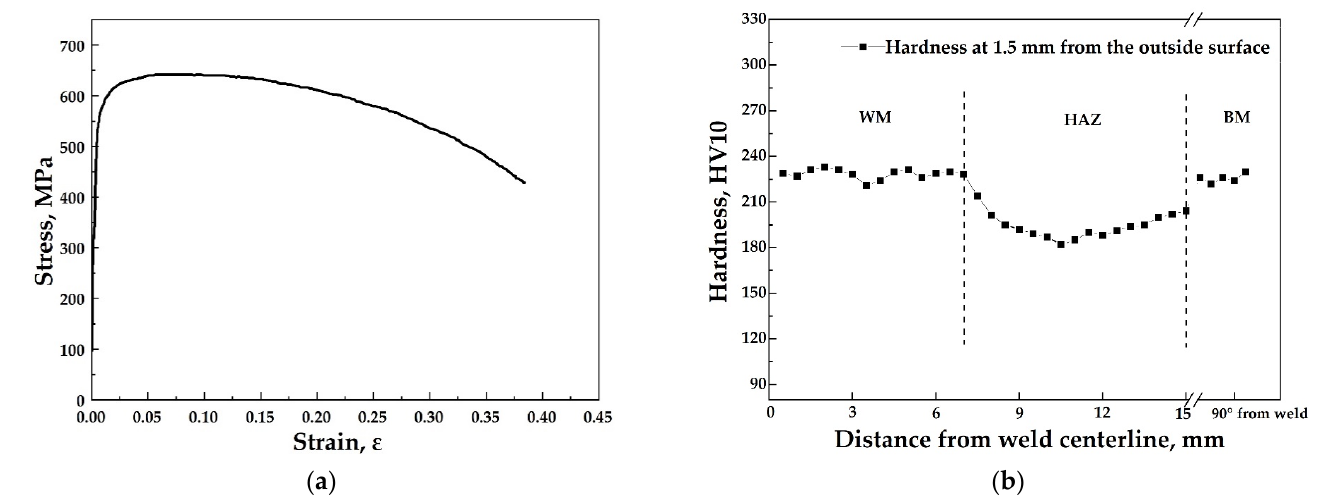
Figure 3. Stress–strain curve ( a ) of the BM, and variation of hardness ( b ) from weld centerline to BM. Table 2. Tensile properties of the pipe.